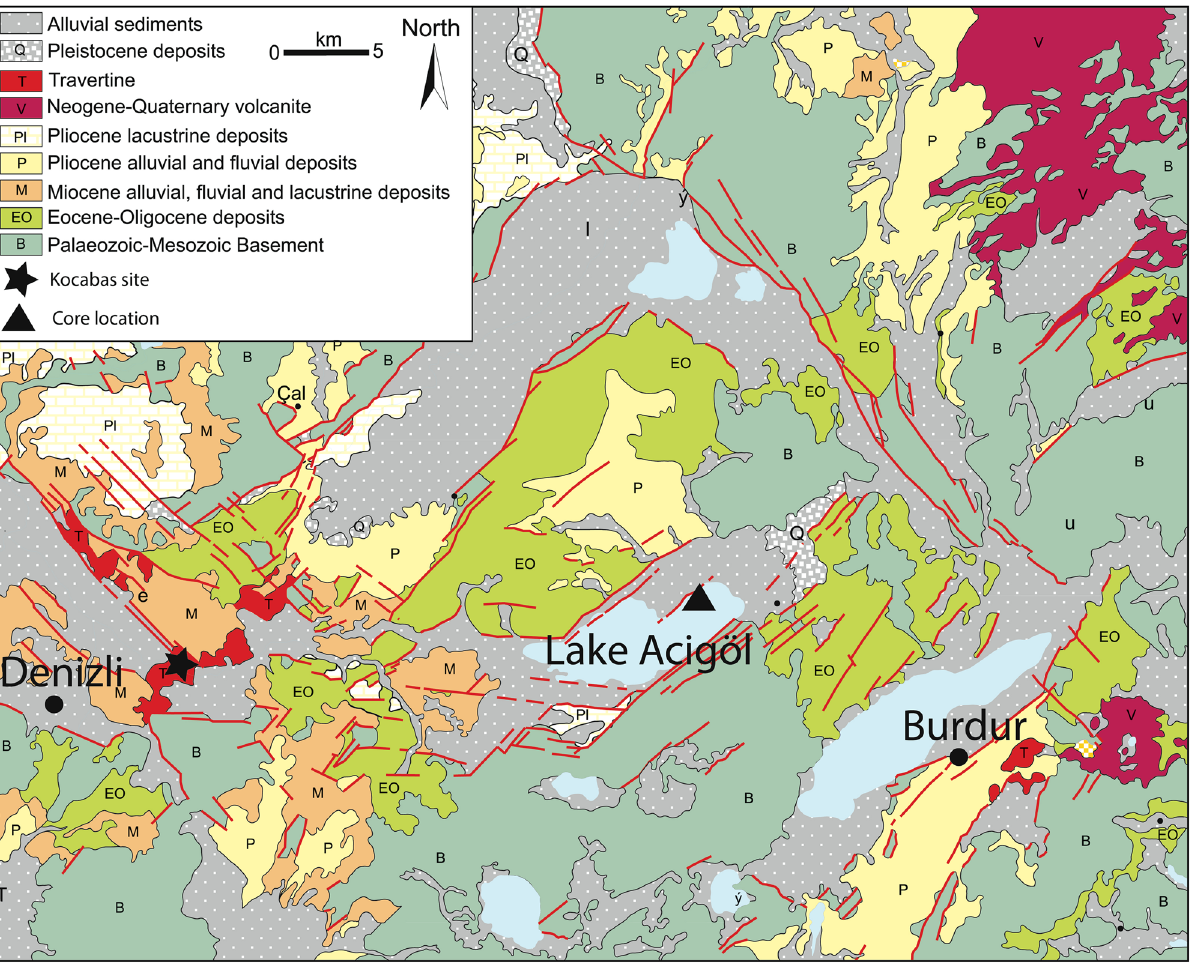
Figure 1. Simplified geological map and location of the sites. Redrawn from Alçiçek et al.